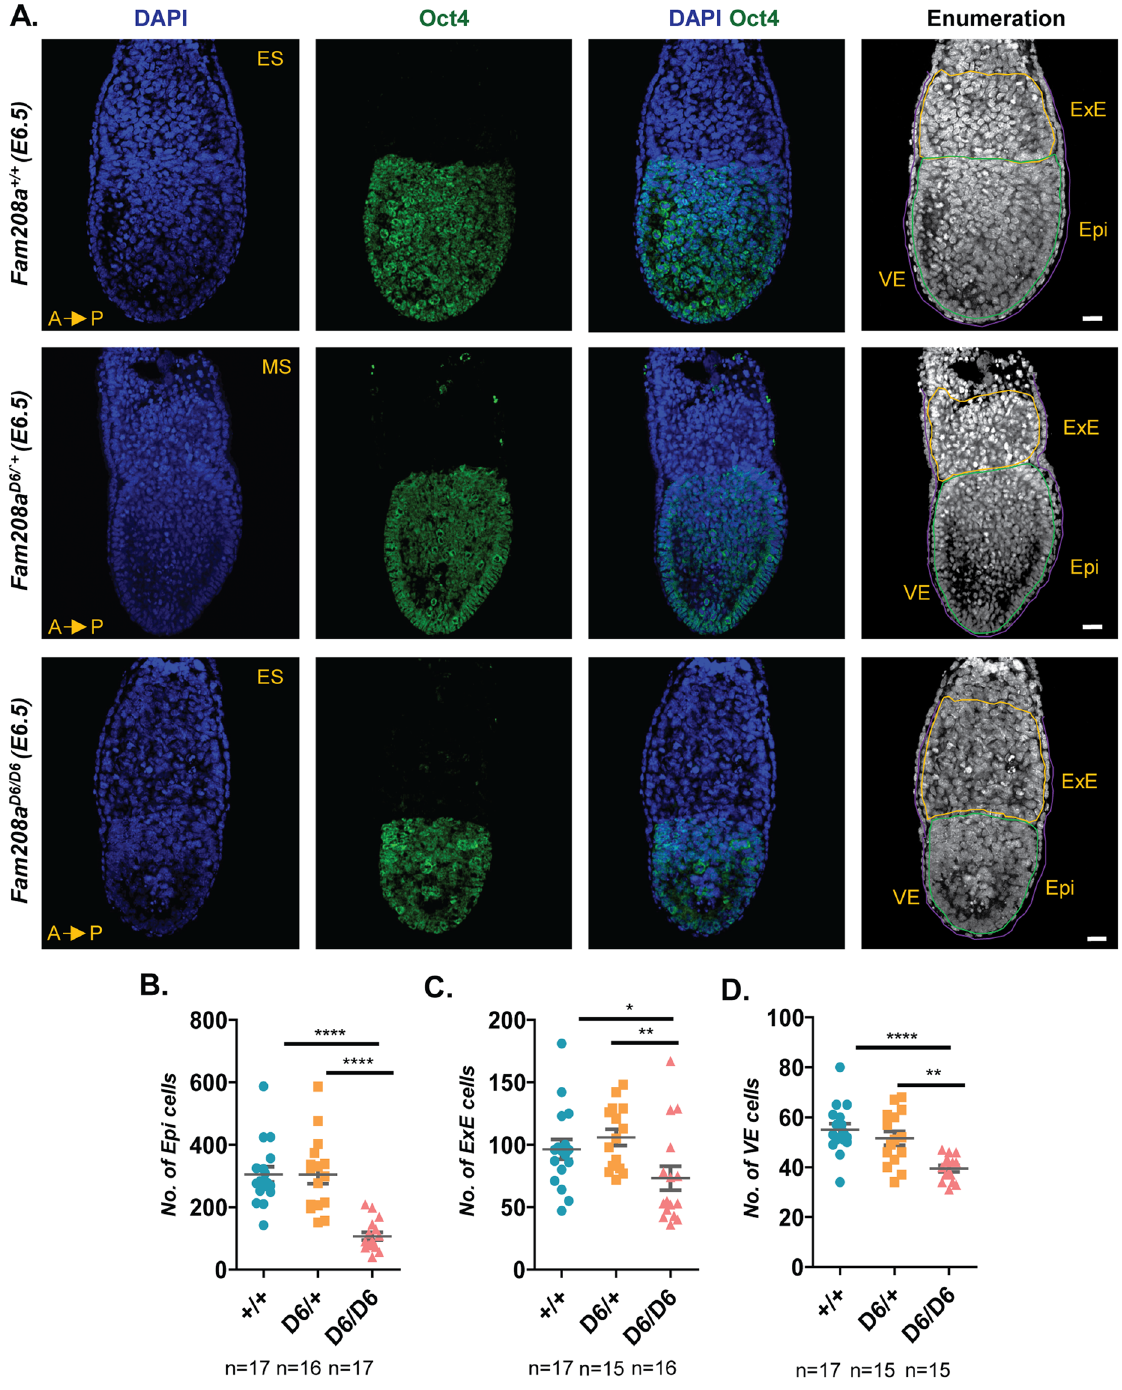
Figure 4. Fam208a D6/D6 mutants have reduced cell numbers. Whole mount immunofluorescence of mutant Fam208a D6/D6 mutant embryos and their wildtype littermate controls at E6.5. ( A ) Confocal images show that mutant embryos have a smaller epiblast as seen by the smaller expression domain of Oct4 (epiblast marker, green). Quantification of ( B ) epiblast, ( C ) ExE and ( D ) VE cell numbers. All results are mean ± SEM from 17 ( Fam208a + / + ), 15 ( Fam208a D6 / + ) and 15 ( Fam208a D6/D6 ) embryos. * p < 0.05, **** p < 0.0001 Scale bar: 50 µ m. ES, Early streak; MS, Mid-streak; ExE, Extra-embryonic ectoderm; Epi, Epiblast; VE, Visceral